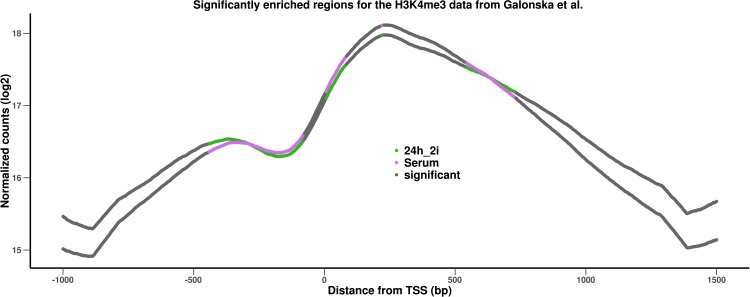
Results of the analysis of the H3Kme3 data from Galonska et al. (2015).The profiles are based on TSS close to identified peaks of the histone modification in the two conditions.